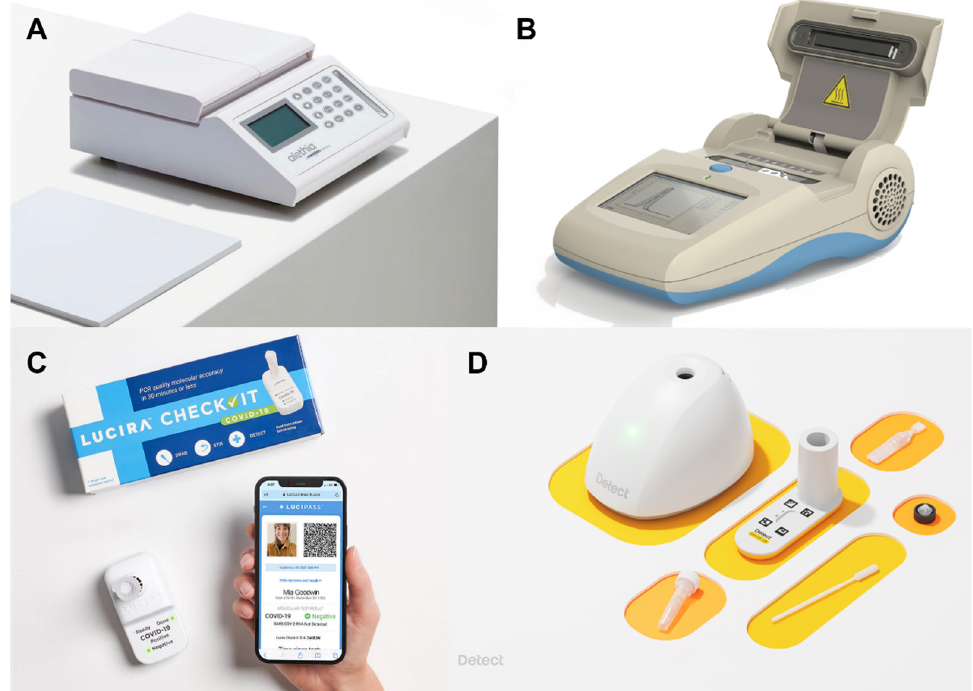
Figure 5. Commercial LAMP devices. ( A ) Alethia portable LAMP platform (top) and DNA extraction prep (bottom). Reprinted with permission from [96]. Copyright 2022, Meridian Bioscience ® . ( B ) Genie III portable LAMP platform. Reprinted with permission from [102]. Copyright 2022, Opti- Gene. ( C ) Lucira™ Check It COVID-19 Test Kit. Reprinted with permission from [103]. Copyright 2022, Lucira. ( D ) Detect COVID-19 Starter Kit™. Reprinted with permission from [104]. Copyright 2022, Detect. Table 2. Specifications of commercial LAMP devices. Data retrieved from [97–104].